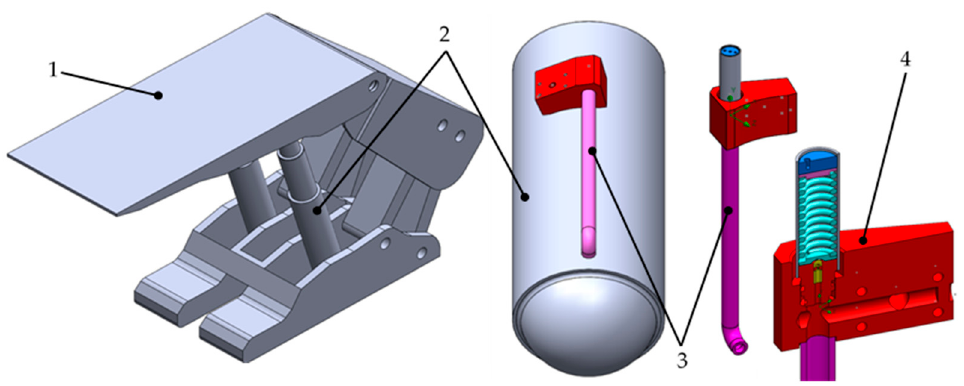
Figure 1. Powered roof support: 1- 2-leg shield, 2- hydraulic leg, 3- safety elements, 4- cross section. Putting the powered roof supports with large diameter hydraulic legs into the longwall operation requires increased flows of the liquid supplying the hydraulic legs, which entails technical problems resulting from the necessity to move a fluid with a high